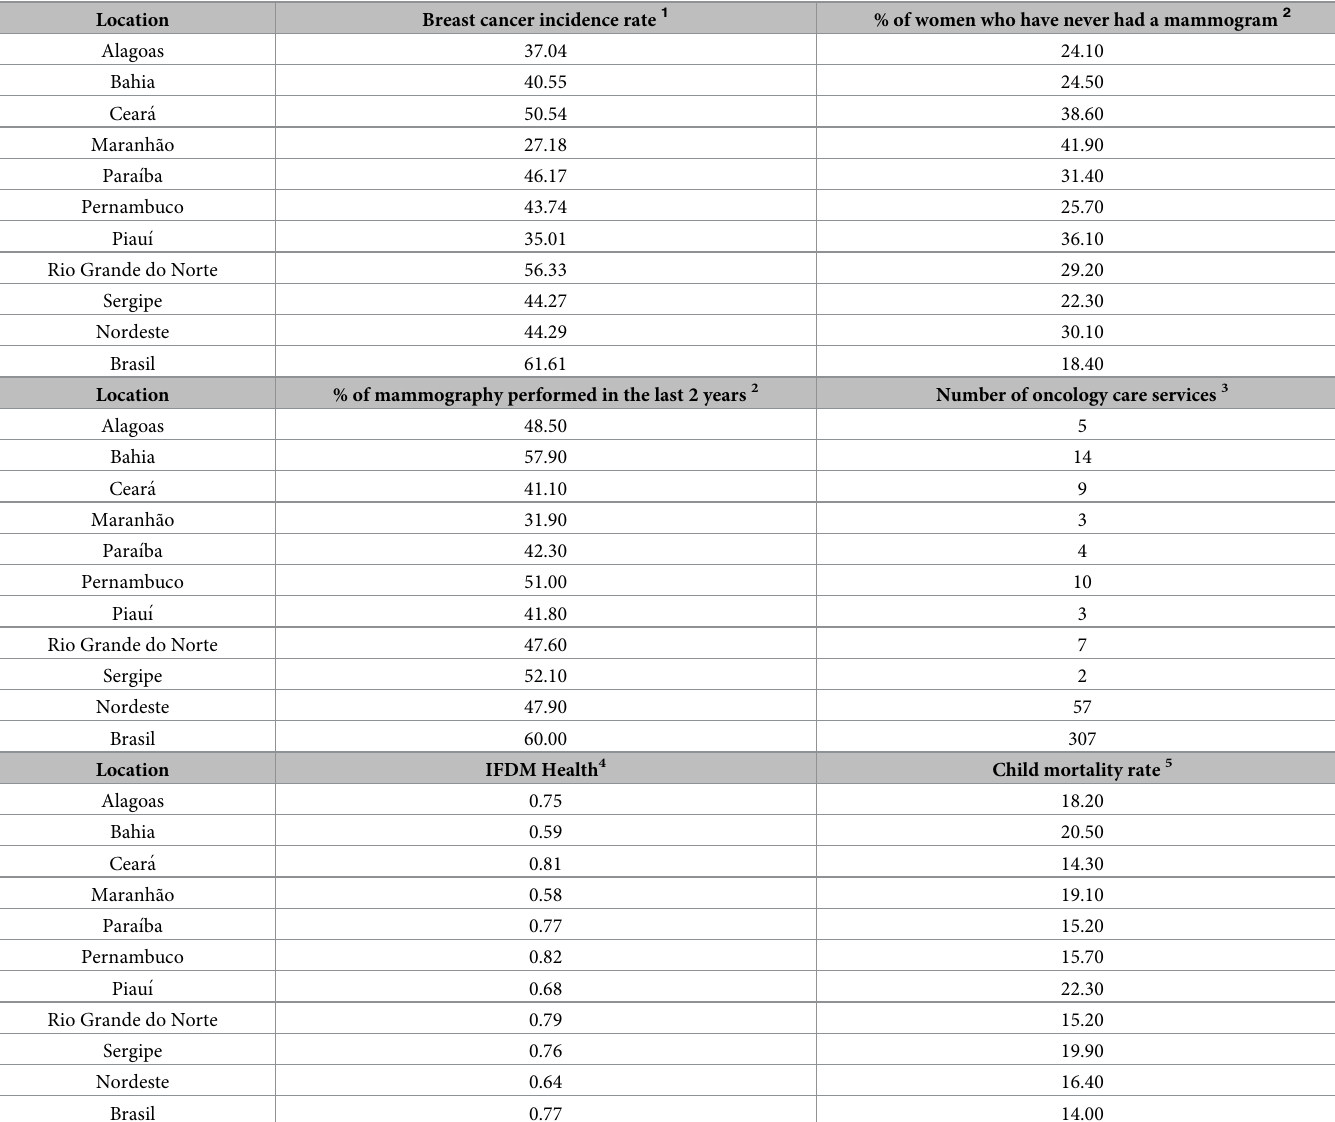
Table 2. The health situation in the states of the Northeast region of